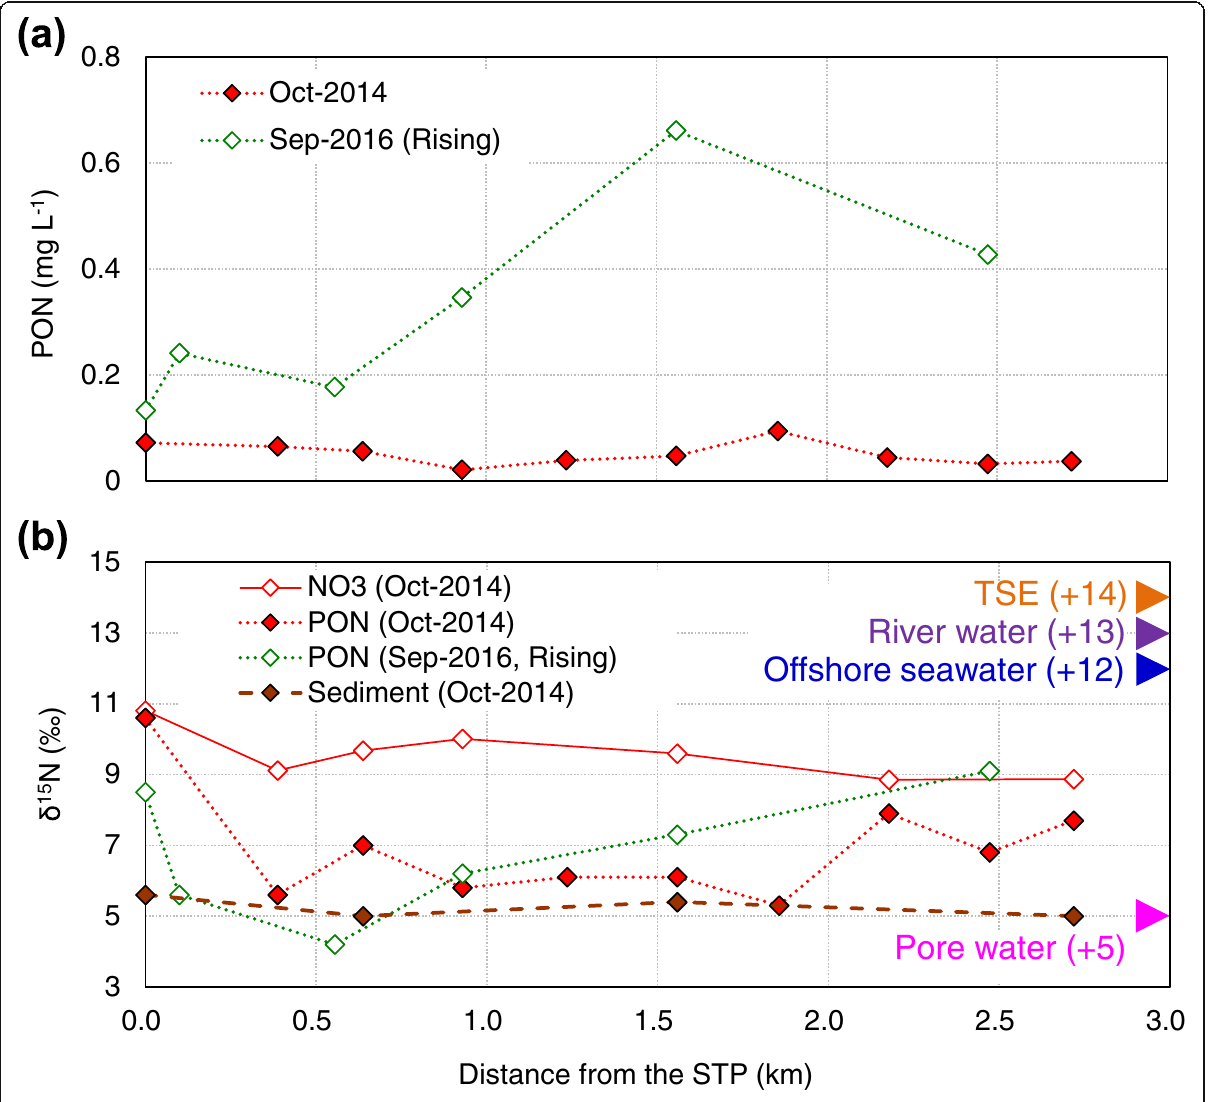
Fig. 7 Spatial variation in a PON concentrations and b δ 15 N values for NO 3 − , PON, and surface sediment on the KH line. The values for PON were measured in October 2014 and during the rising tide period in September 2016. The δ 15 N values for NO 3 − and sediment were measured in October 2014. The average δ 15 N(NO 3 − ) for TSE, river water, offshore seawater, and pore water from 2013, 2013 and 2014, 2014, and 2013, respectively, served as reference